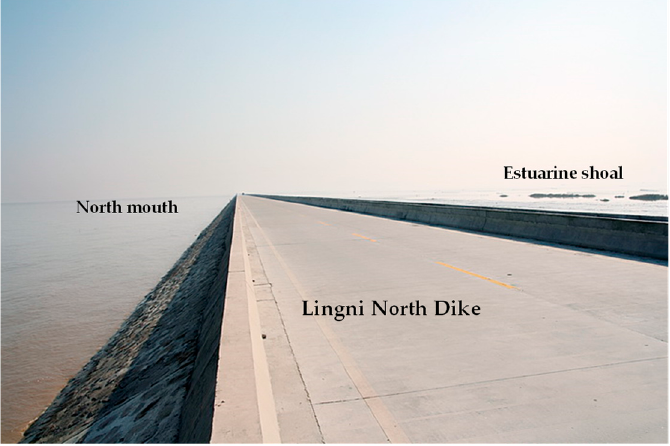
Figure 12. Current situation of Lingni North Dike.